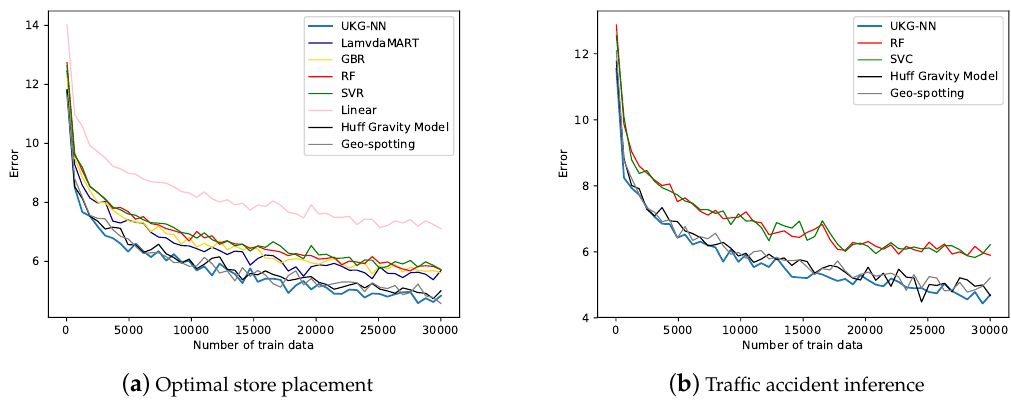
Figure 5. Effectiveness of Urban KG:error vs. number of train